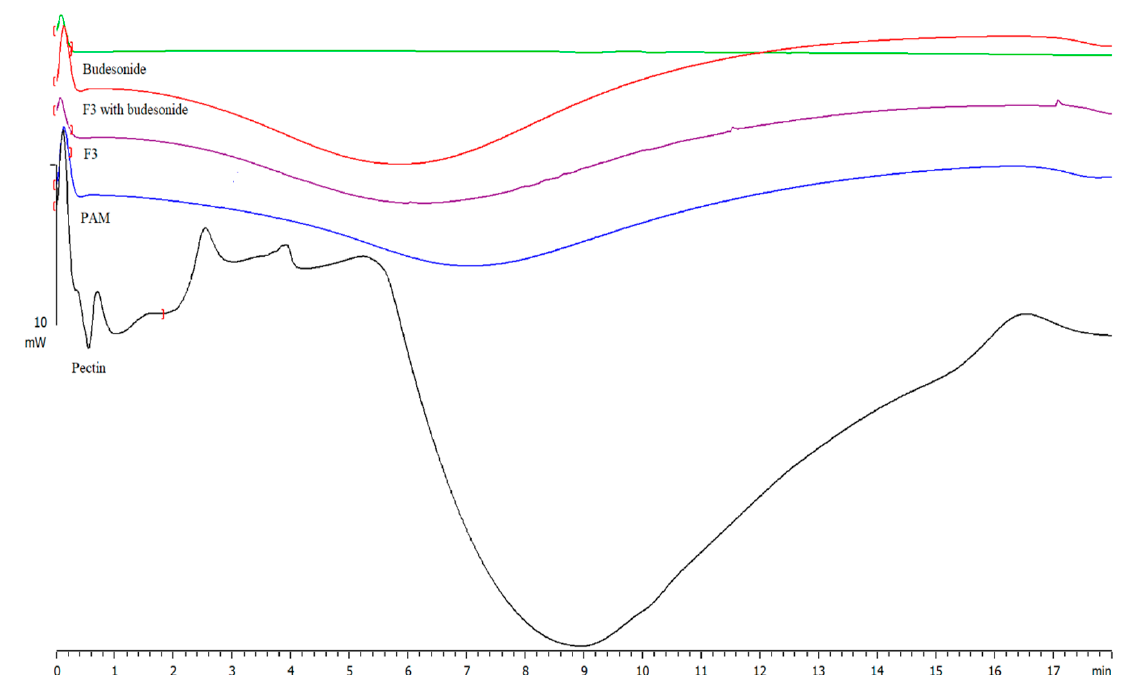
Figure 7. DSC thermogram of pure pectin, polyacrylamide, F3 without the drug, F3 with drug and budesonide.